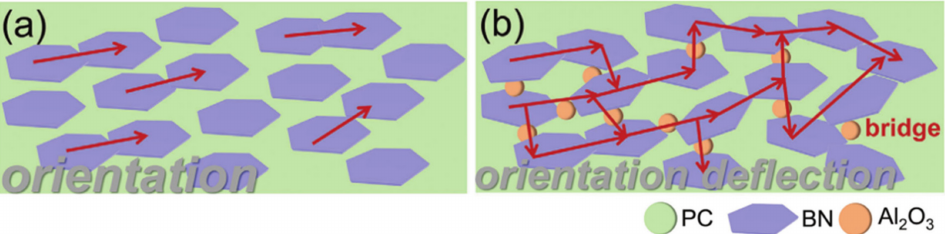
Figure 4. Schematic representation of heat flux in polycarbonate/BN/Al 2 O 3 composites ( a ) oriented BN platelets for high in-plane thermal conductivity, ( b ) oriented BN platelets with spherical Al 2 O 3 acting as abridge for both high in-plane and through-plane thermal conductivity [32] (Copyright (2021) with permission from Wiley Periodicals,